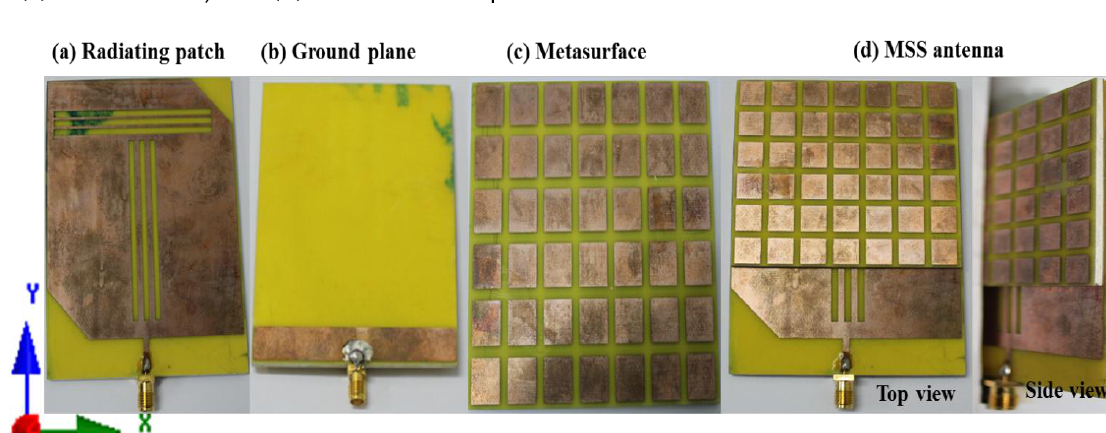
Figure 8. Photograph of fabricated prototype of ( a ) radiating patch; ( b ) ground plane; ( c ) metasurface; and ( d ) metasurafce superstrate loaded